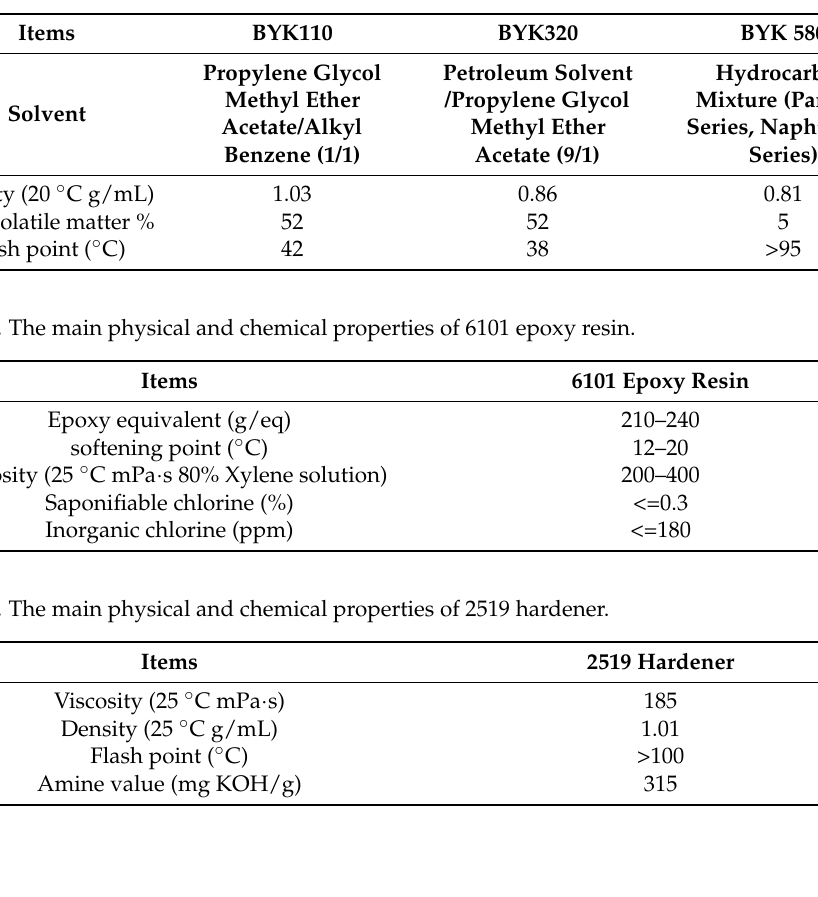
Table 1. The main physical and chemical properties of assistant agent.